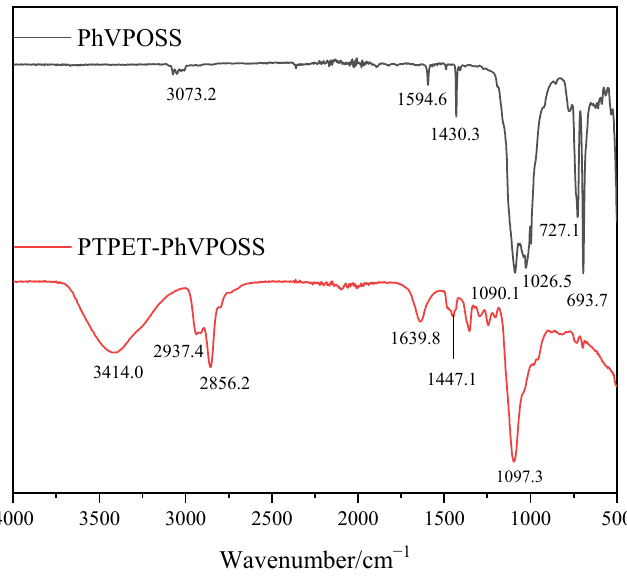
Figure 9. FT-IR analysis of PTPET-PhVPOSS.